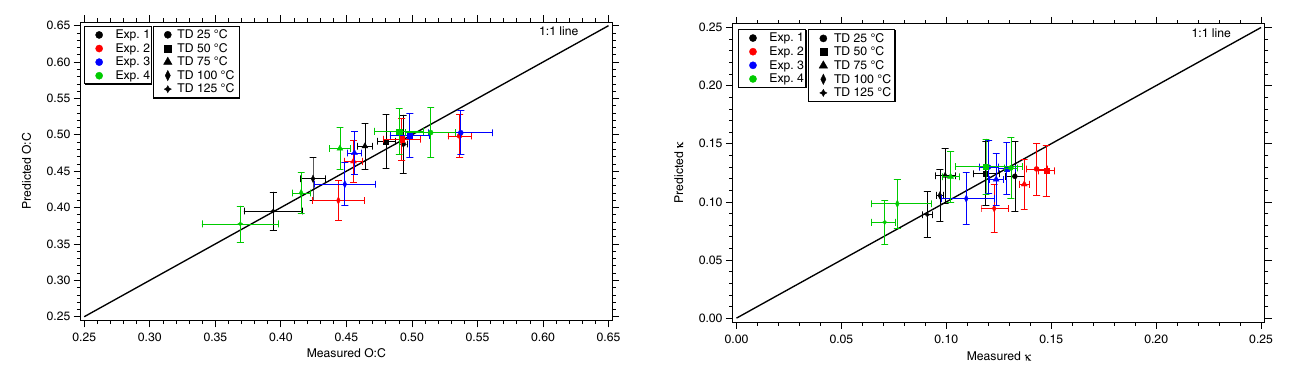
Figure 9. The predicted versus measured κ ’s for all TD tempera- tures in all of the experiments. The color indicates the experiment number, and the symbol indicates the TD temperature. The error bars for the predicted κ ’s were obtained by predicting the κ ’s using the κ distribution at ± 1 standard deviation in Fig. 7b.